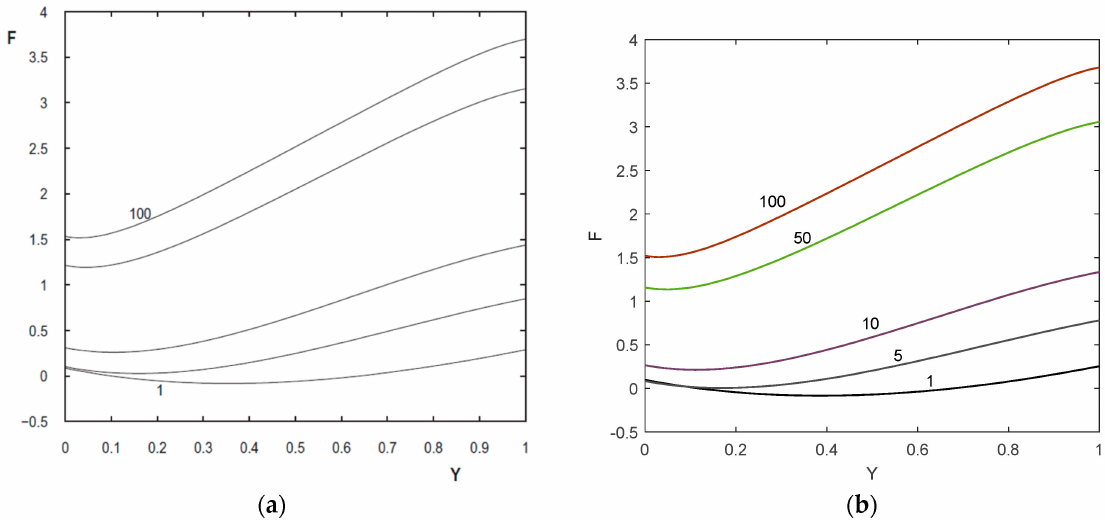
Figure 2. Comparison of temperature profiles of the previous results reported by Cimpean and Pop [52] ( a ) and the present results ( b ).